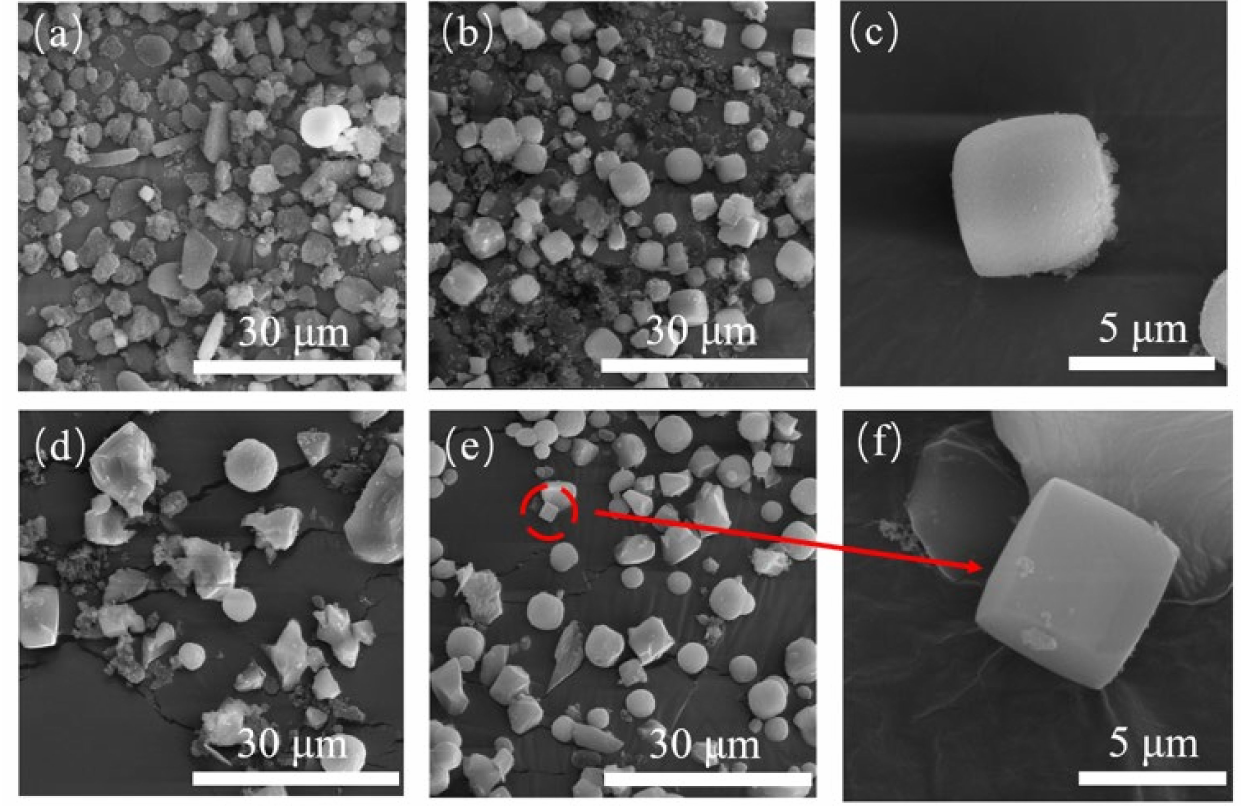
Figure 2. SEM diagrams of S-1( a ), S-2 ( b , c ), S-3 ( d ) and S-4 ( e , f